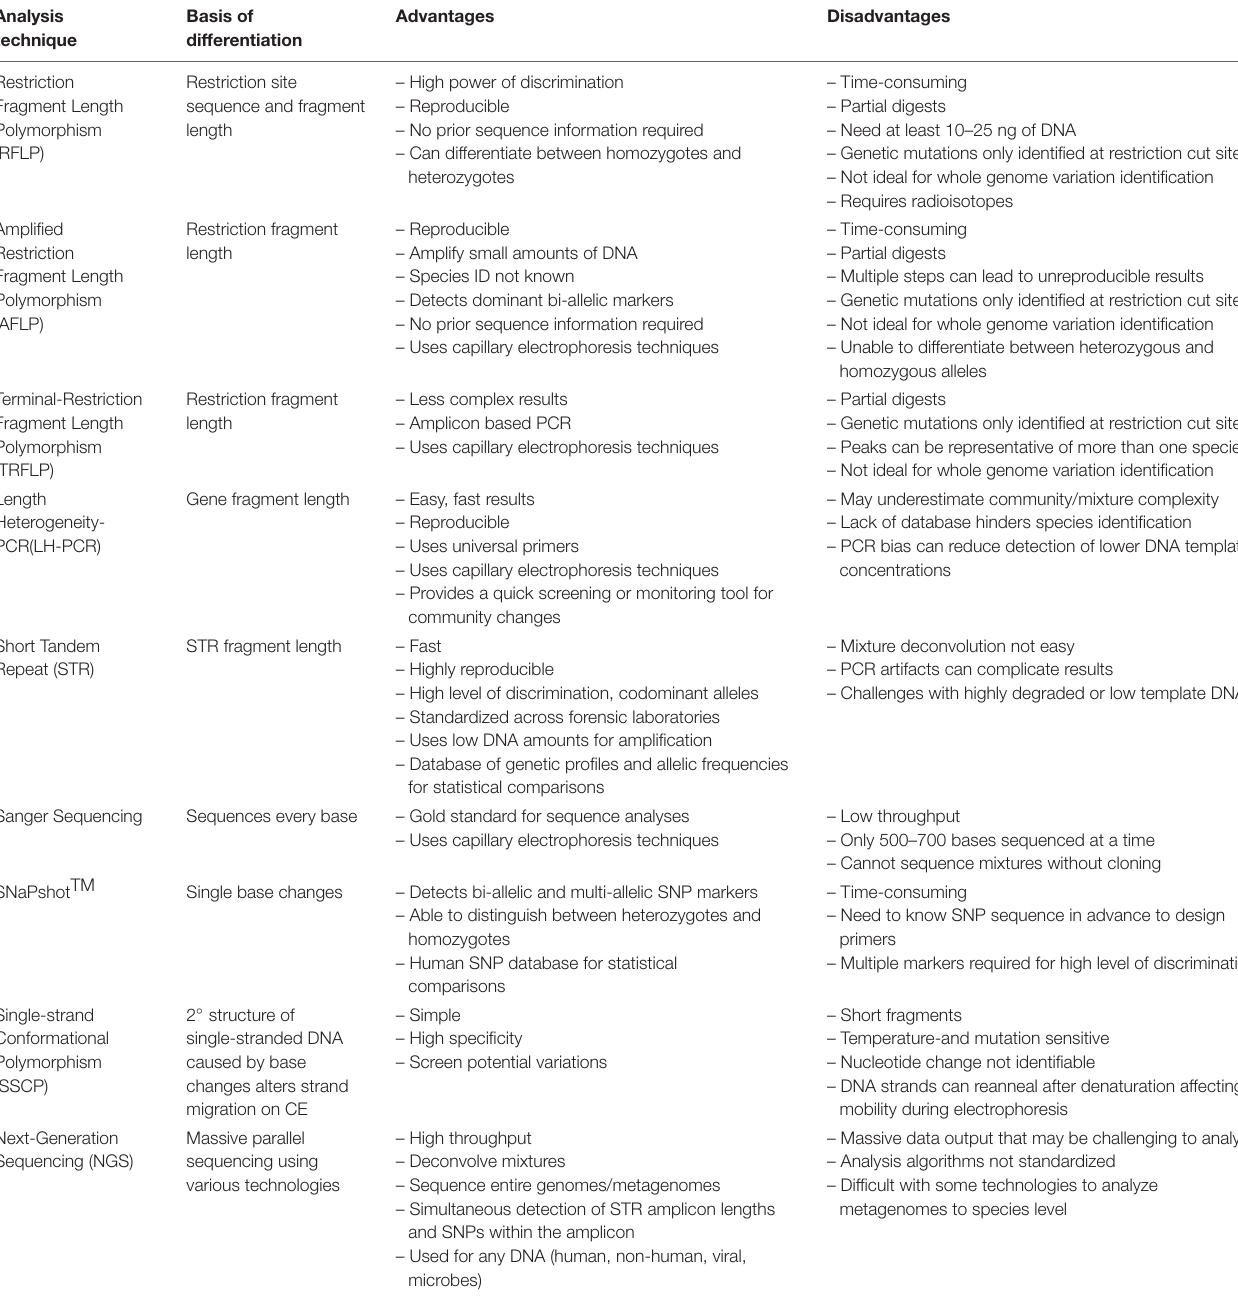
TABLE 1 | The basis of differentiation, advantages, and disadvantages of past and current